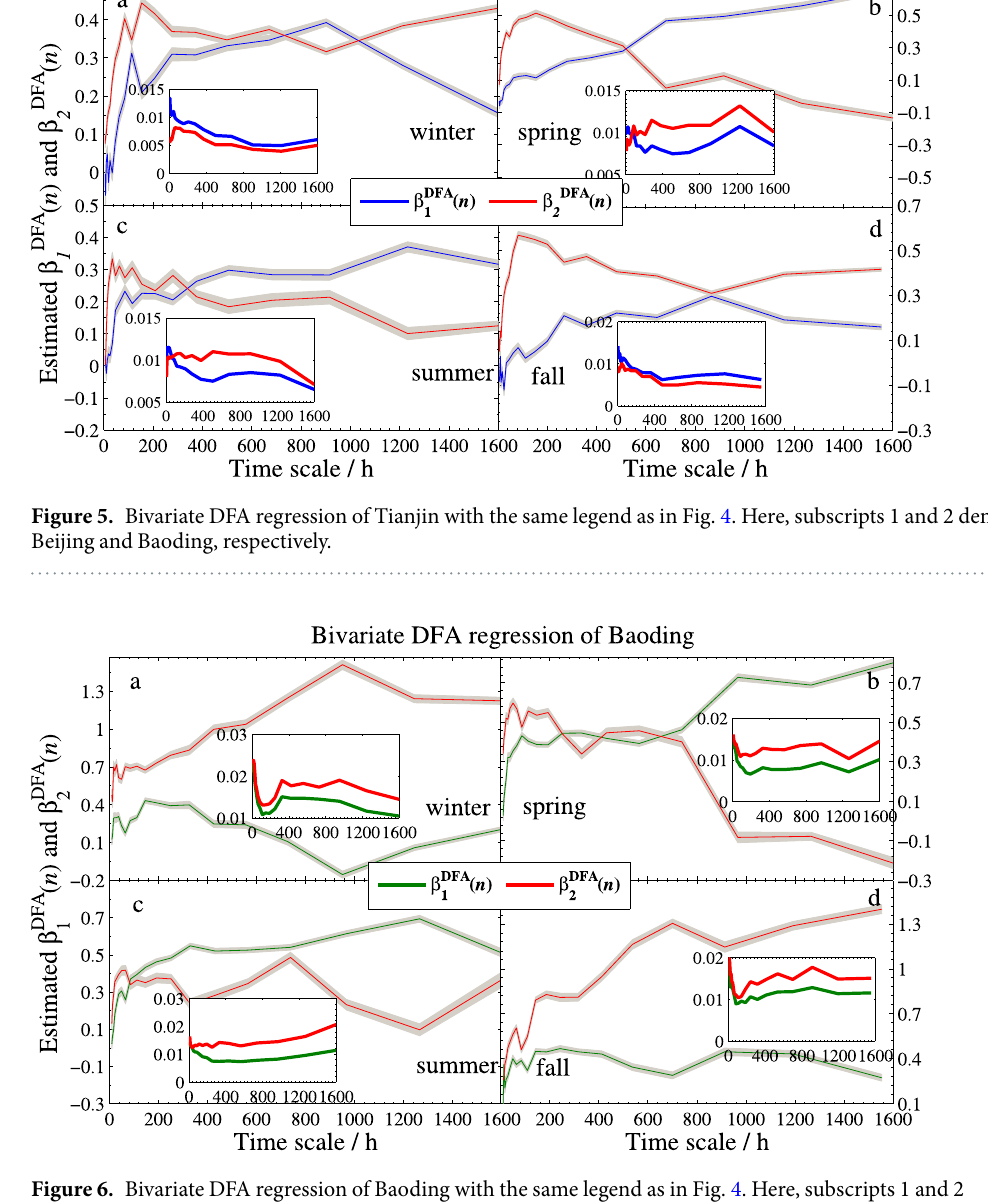
Figure 6. Bivariate DFA regression of Baoding with the same legend as in Fig. 4. Here, subscripts 1 and 2 denote Beijing and Tianjin,